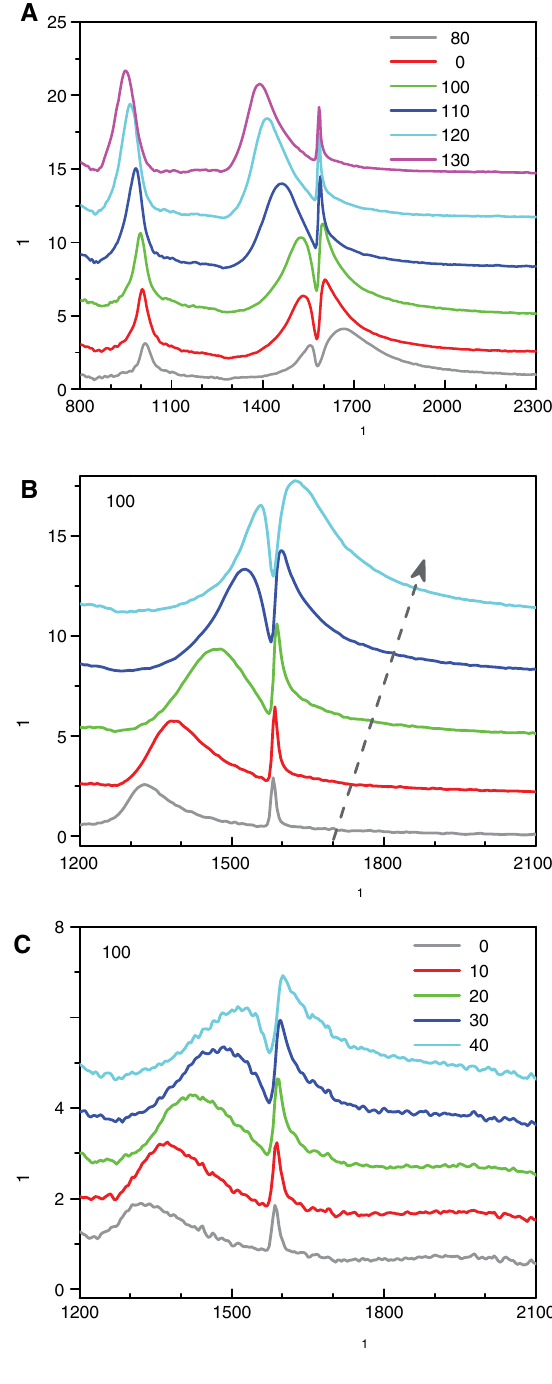
Figure 8 Tunable phonon-induced transparency through (A) ribbon width control, (B) chemical doping, and (C) electrostatic gating (A–C adapted with permission from [56], Copyright 2014 American Chemical Society).